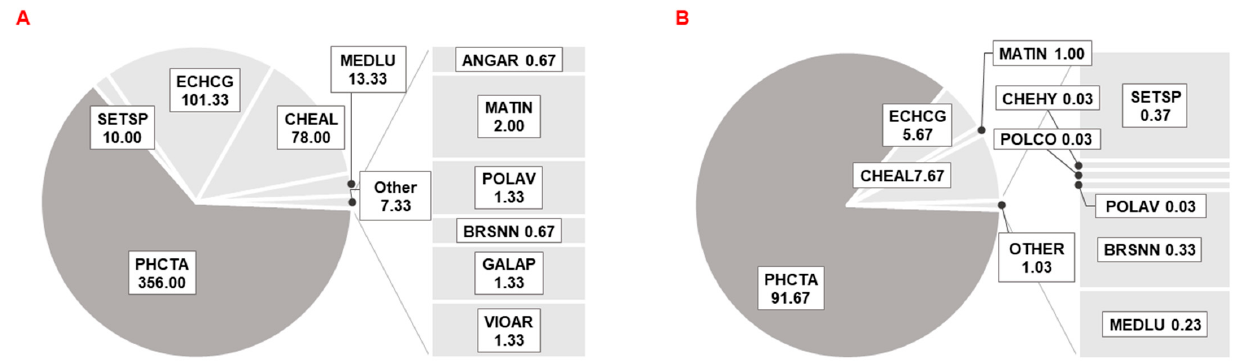
Figure A1. Number of plants per m 2 —Sowing 1 (12th of April) in 2018 ( A ) and leaf coverage in %—Sowing 1 (12th of April) in 2018 ( B ).